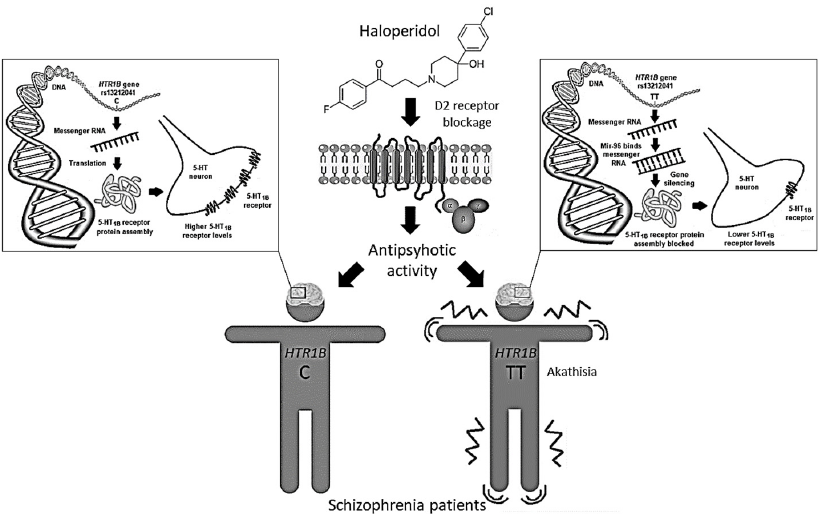
Figure 2. The rs13212041 HTR1B gene polymorphism located in the distal 3 ′ -UTR of messenger RNA disrupts the binding site for the microRNA, miR-96, influencing 5-HT 1B receptor expression. Haloperidol-treated schizophrenia patients carrying the HTR1B TT genotype, who have lower levels of 5-HT 1B receptors, develop akathisia more frequently and severely than carriers of the C-allele.